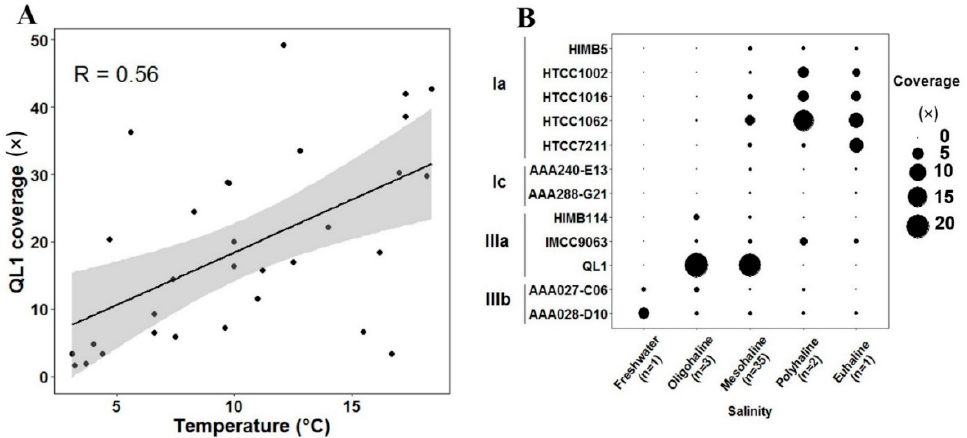
Figure 4. Spatiotemporal variation of SAR11 populations. ( A ) Correlation of relative QL1 abundance with temperature. ( B ) Relative abundance of representative SAR11 bacteria along the salinity gradient over the Baltic Sea surface waters: freshwater ( < 0.5 PSU), oligosaline (0.5–5), mesosaline (5–18), polysaline, (18–30), and eusaline ( > 30). The number of datasets used is shown in parentheses.